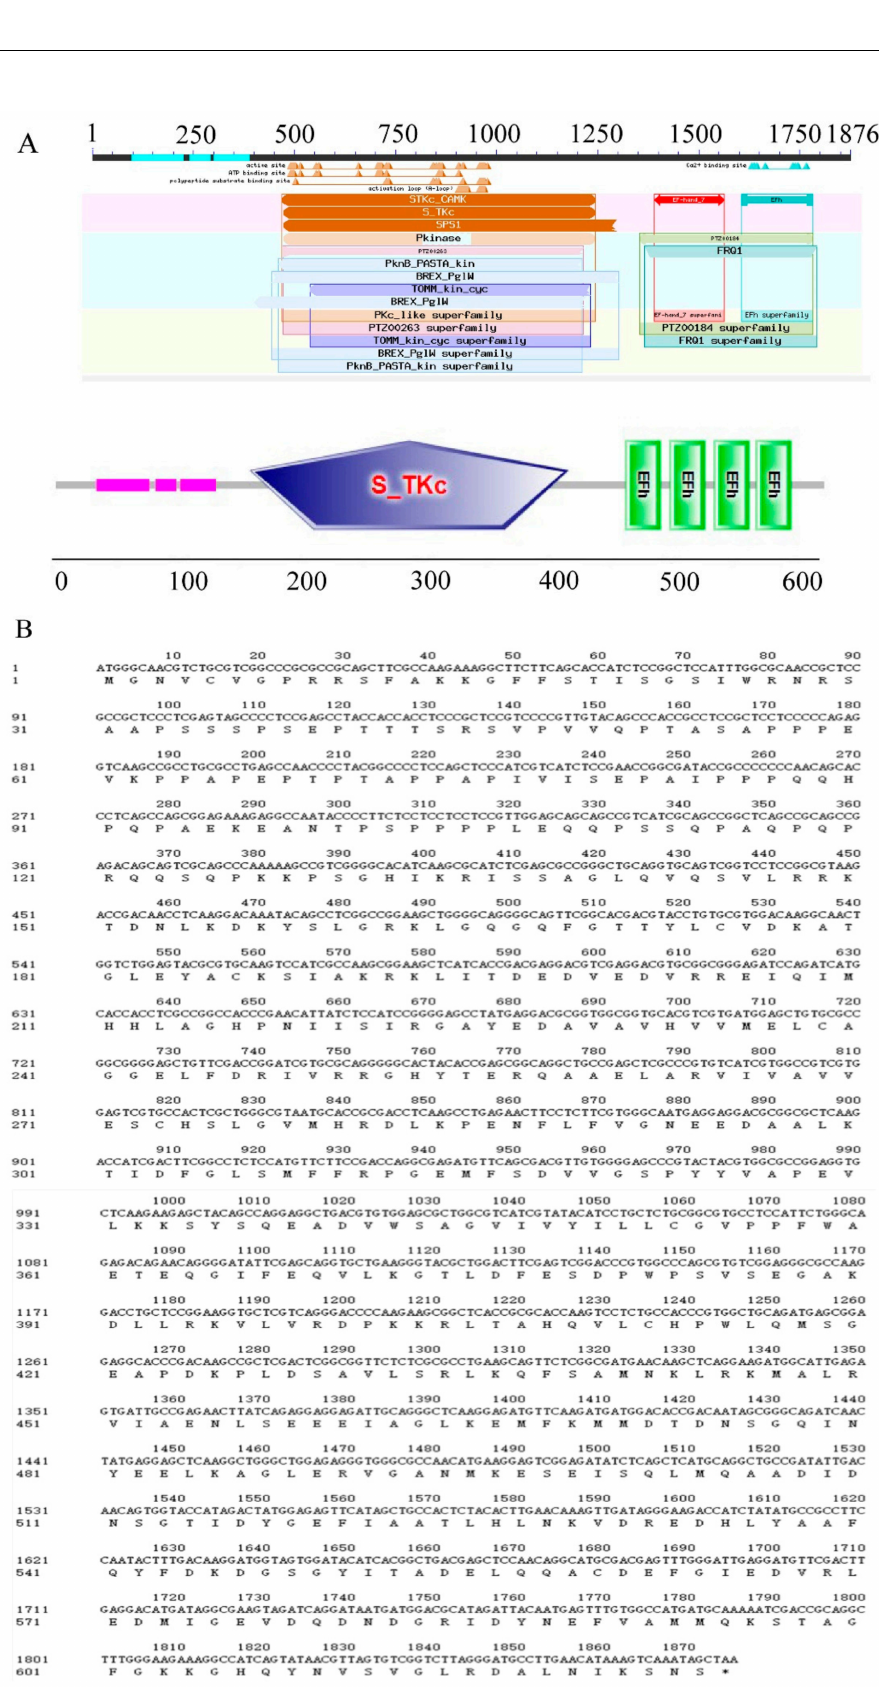
Figure 2. Conserved domain analysis of a calcium-dependent protein kinase gene, TaCDPK27 , in wheat. ( A ) Domain structure of TaCDPK27. TaCDPK27 protein contained an N-terminal variable domain, a serine/threonine kinase-like domain (S-TKc), and four EF-hand motifs. ( B ) Nucleotide and amino acid sequences of